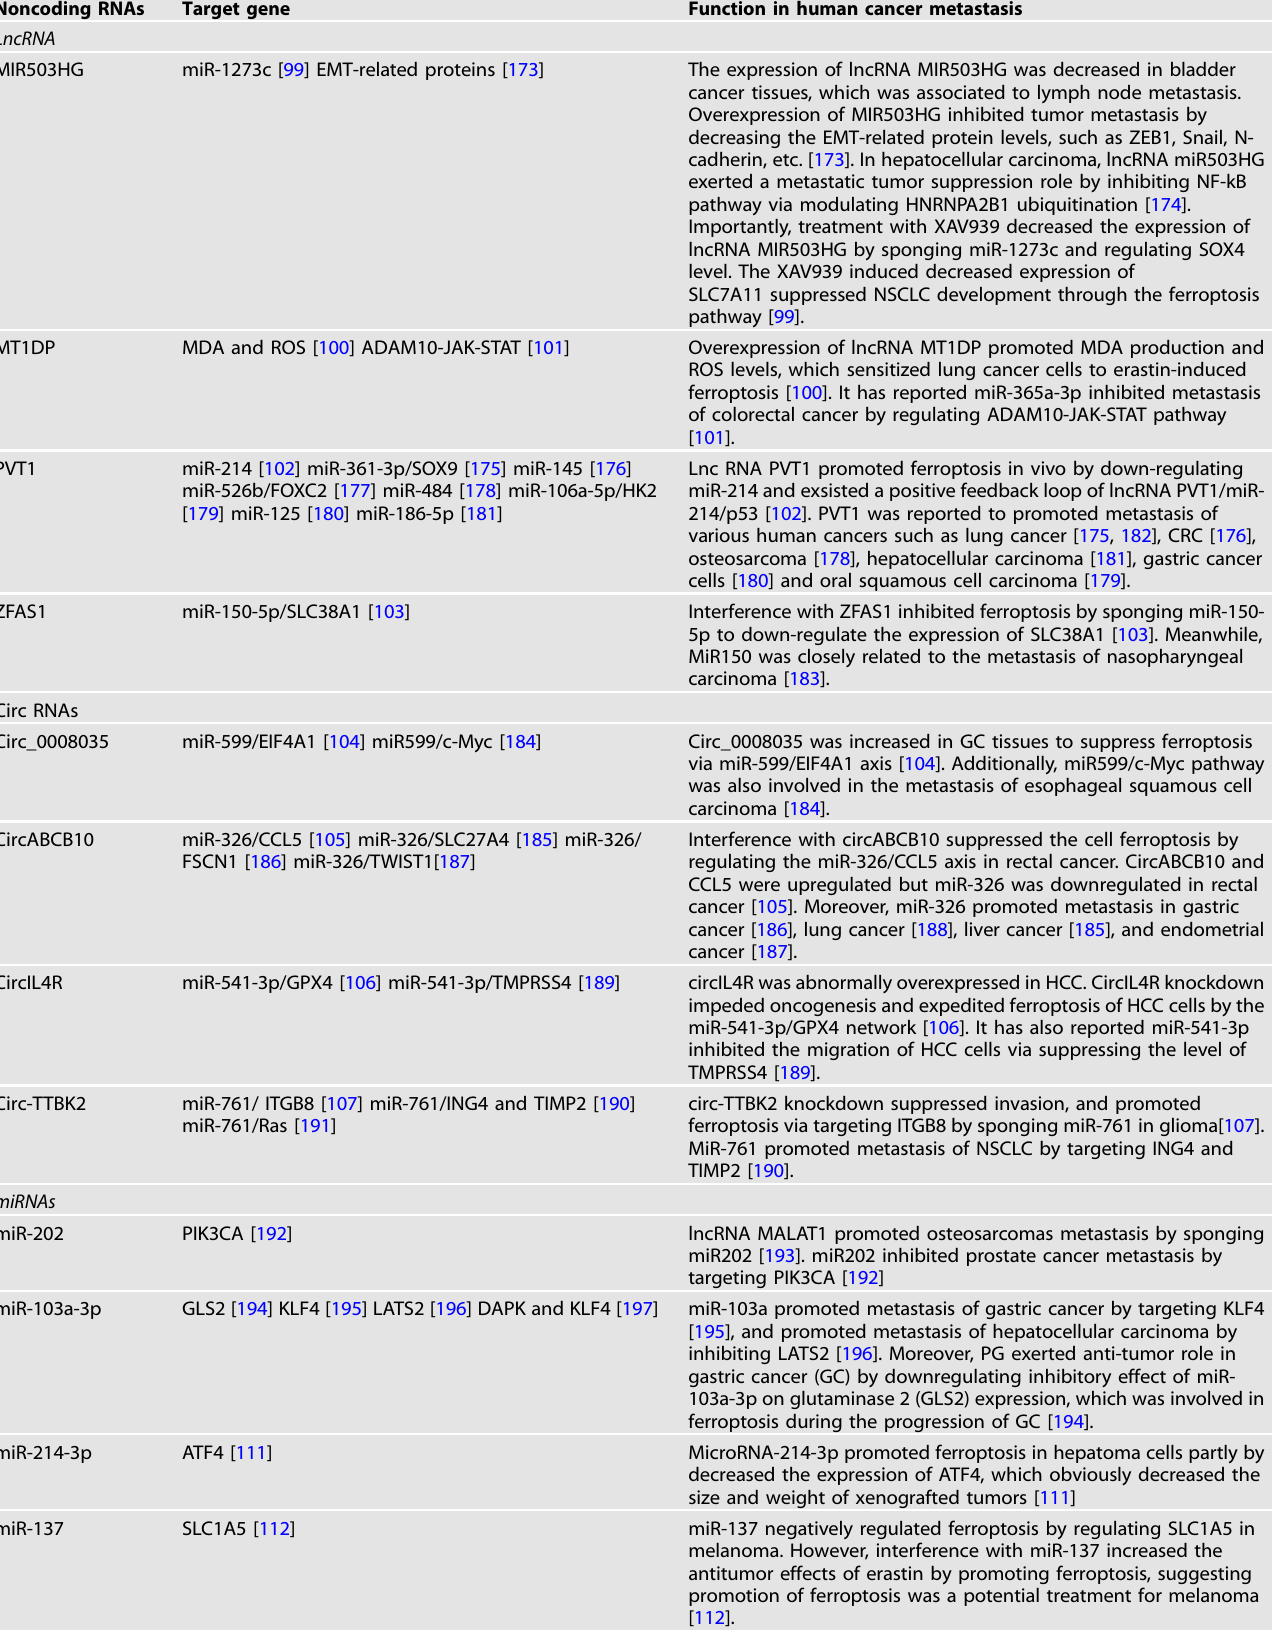
Table 3. Noncoding RNAs regulates ferroptosis in cancer